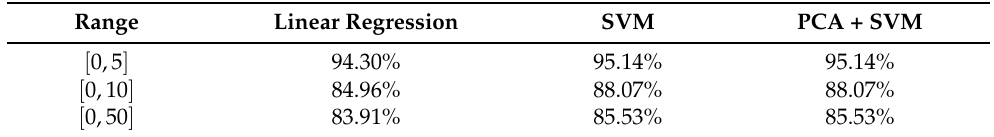
Table 1. The accuracy of different machine learning models with asynchronous attack model with k = 7 bits: linear regression, SVM, and PCA + SVM, where range is the input parameter of the random noise function called before encryption.